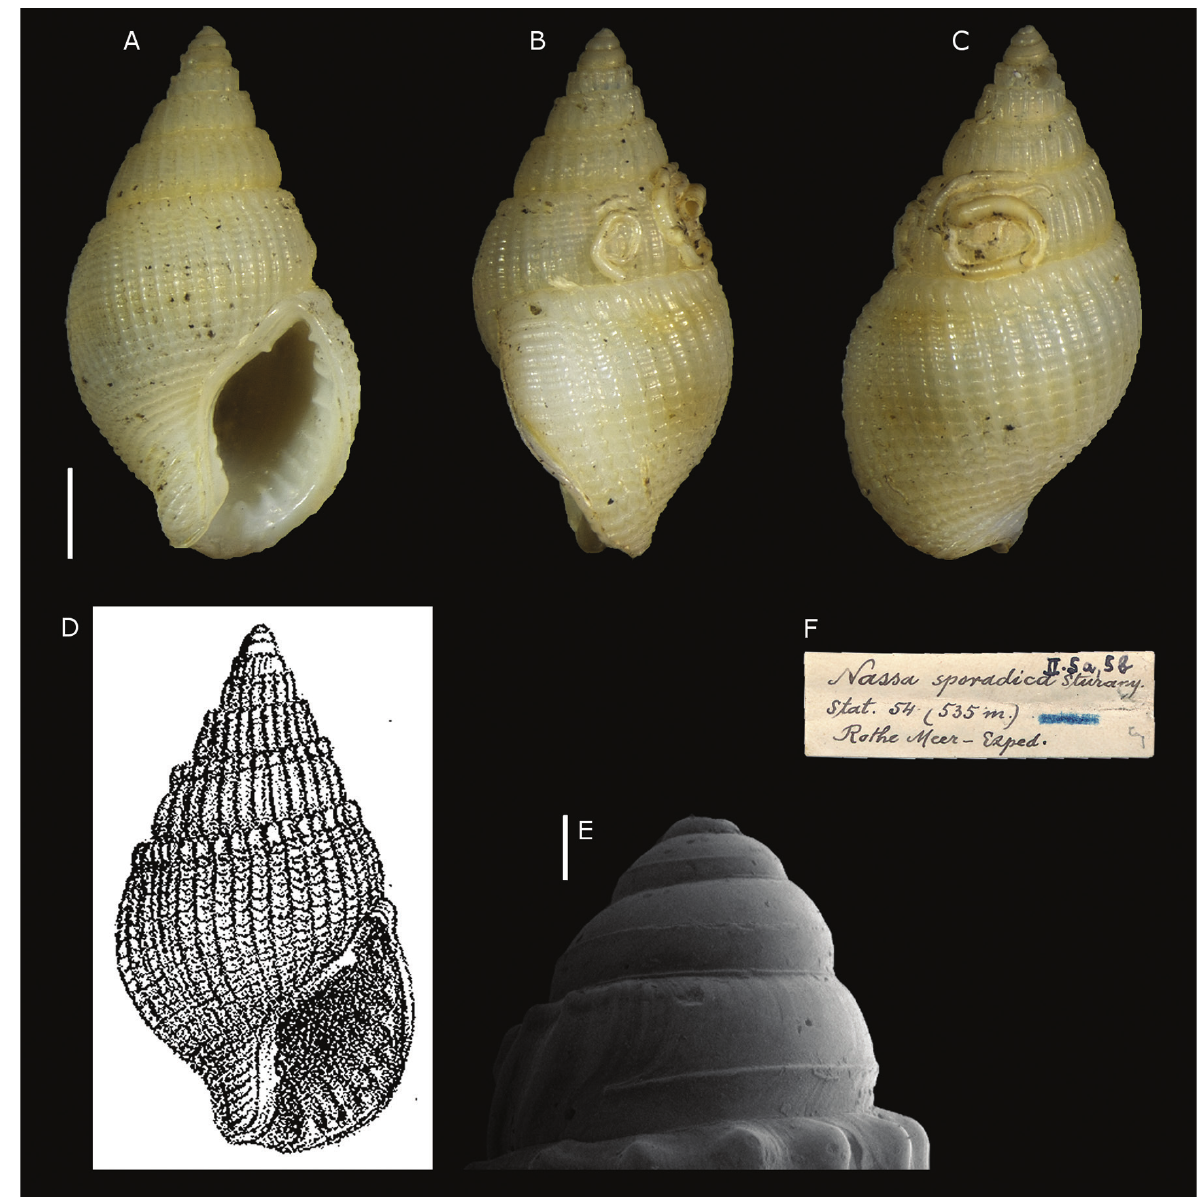
Figure 14. Nassa sporadica Sturany, 1900, Station 54 (Central Red Sea). A–C , E. Holotype, NHMW 84194: front ( A ), right side ( B ), back ( C ), protoconch ( E ). D . Original figure by Sturany (1903). F . Original holotype label. Scale bars: A–C : 2 mm, E : 0.2 mm.